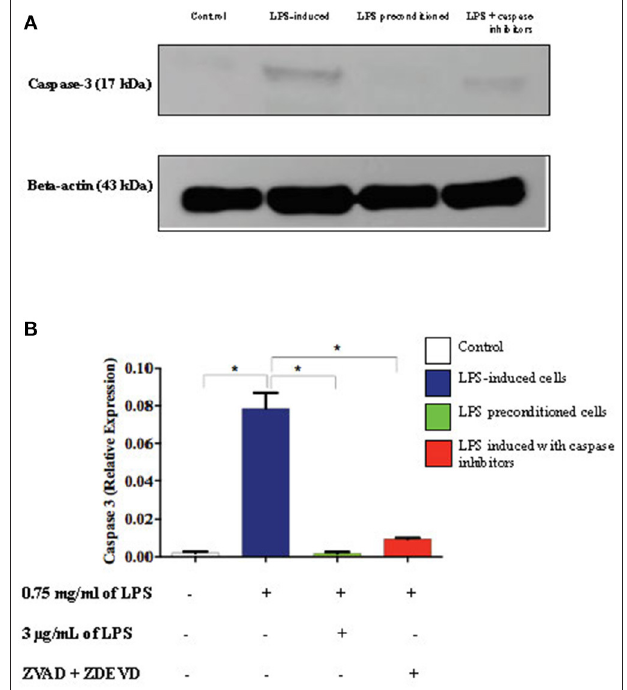
FIGURE 19 | Expressions of caspase-3. (A) The expressions of caspase-3 was determined in whole cell lysates by western blotting. Band densities were measured by densitometric analysis, and data were normalized to the control and expressed as fold change relative to beta-actin. (B) Bars represent data from three independent experiments. Caspase-3 expressions in LPS-induced cells, LPS-pre-conditioned cells, and LPS-induced cells with caspase inhibitors were compared to the control. * p < 0.05, as determined by one-way ANOVA with Bonferroni’s